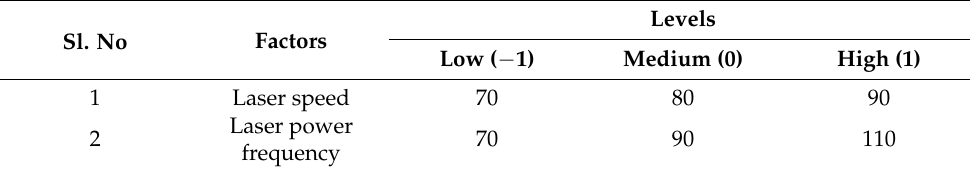
Table 1. List of factors and levels considered for regression